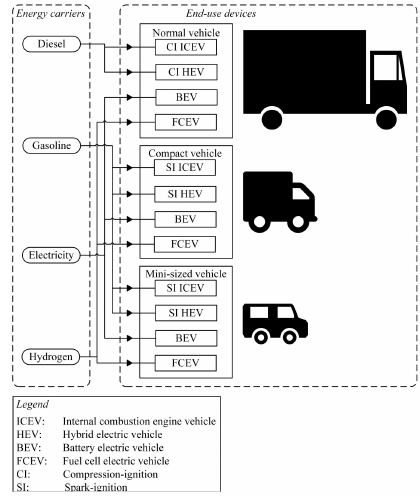
Figure 1. Energy system